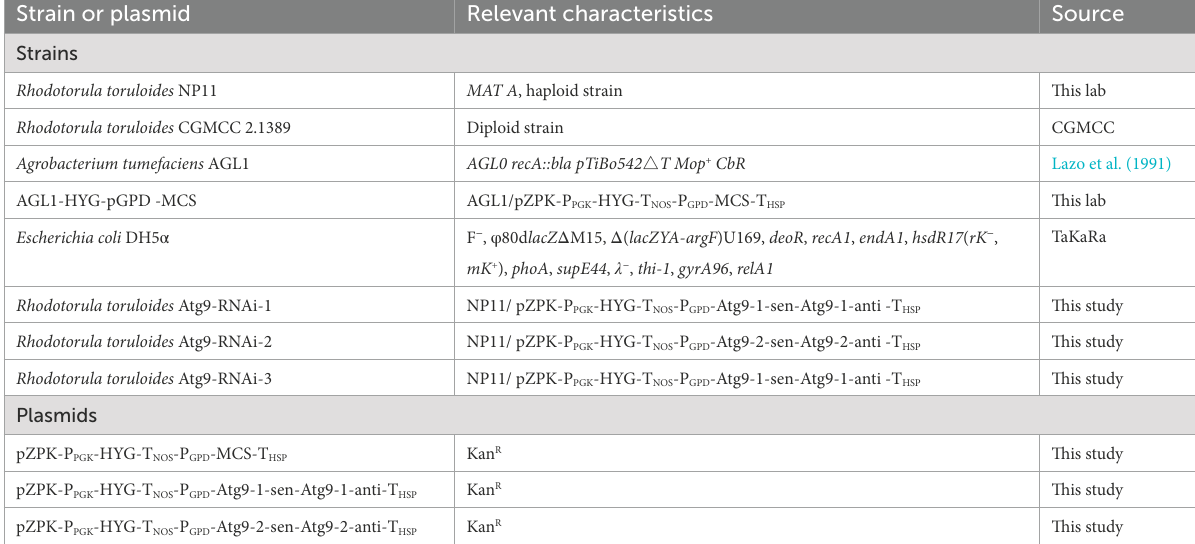
TABLE 1 Strains and plasmids used in this